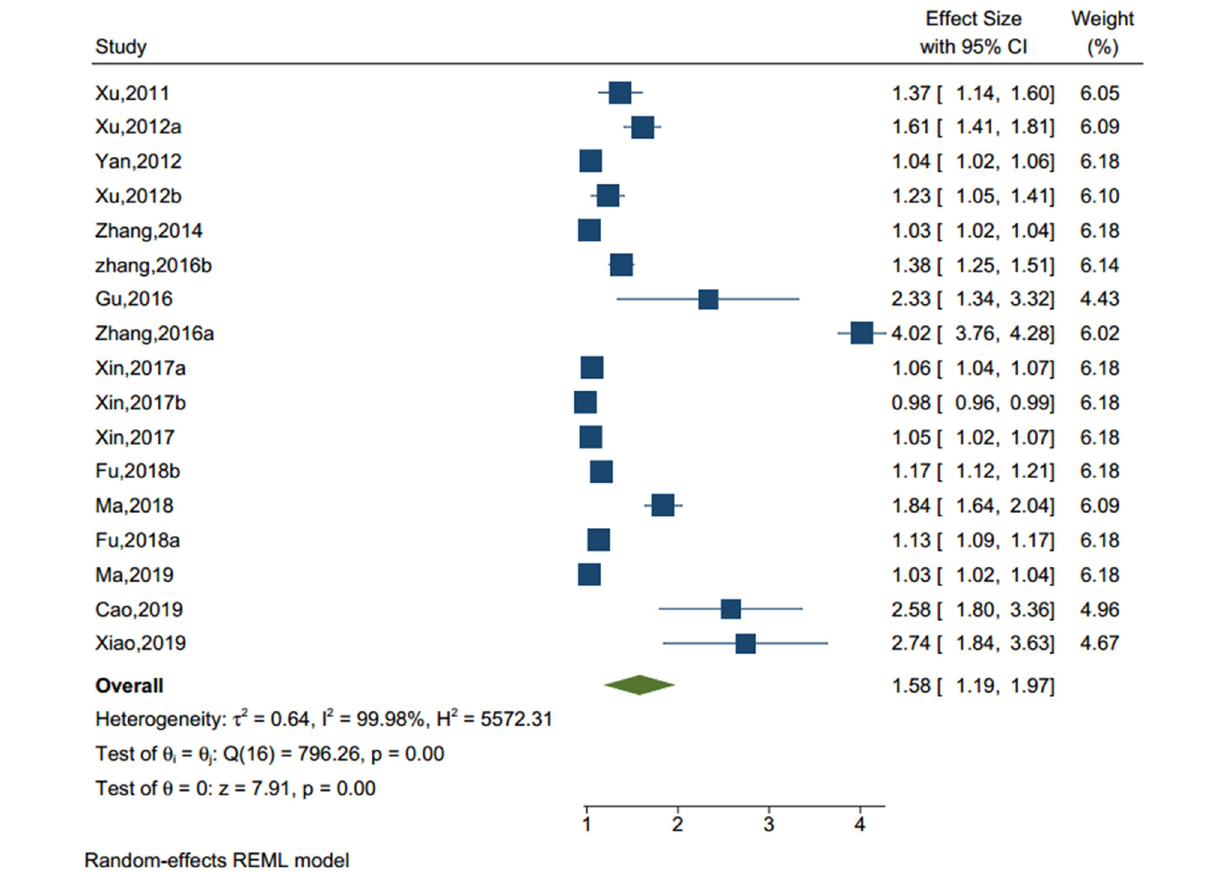
FIGURE 7 | Forest plot of studies including mental health problems factor.